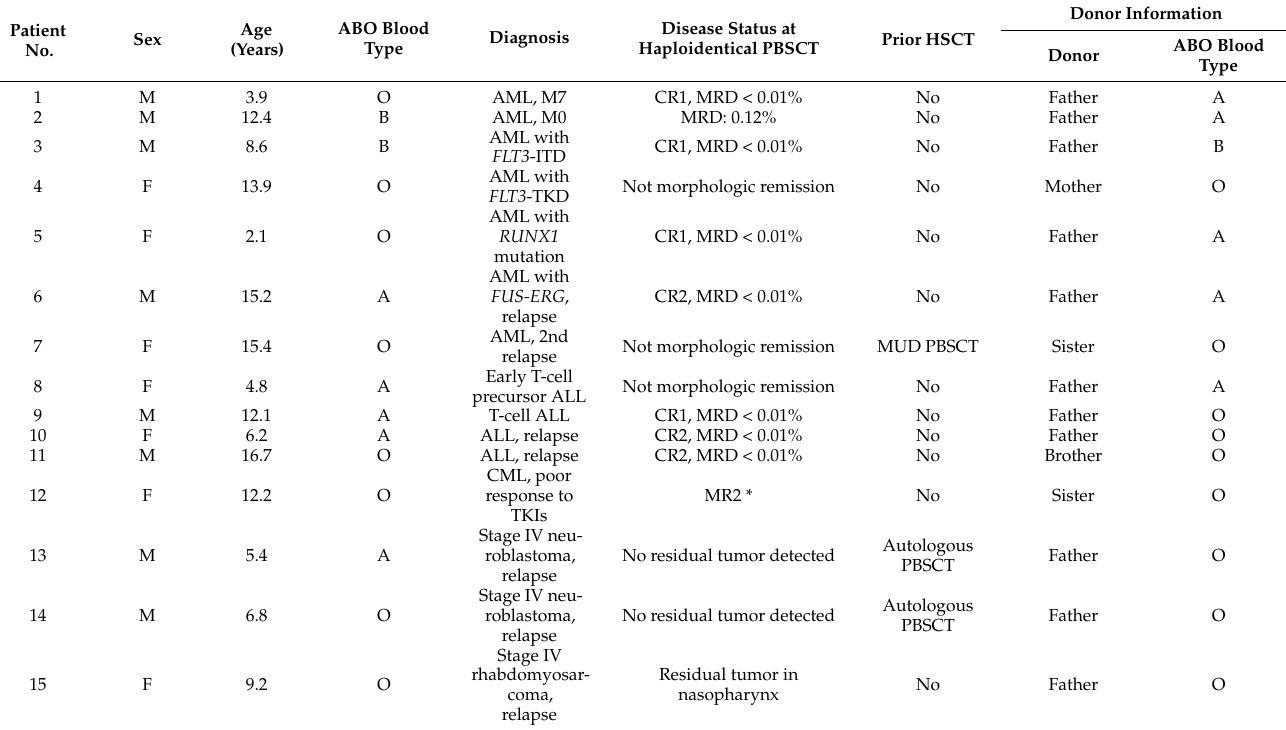
Table 1. Patient characteristics and donor